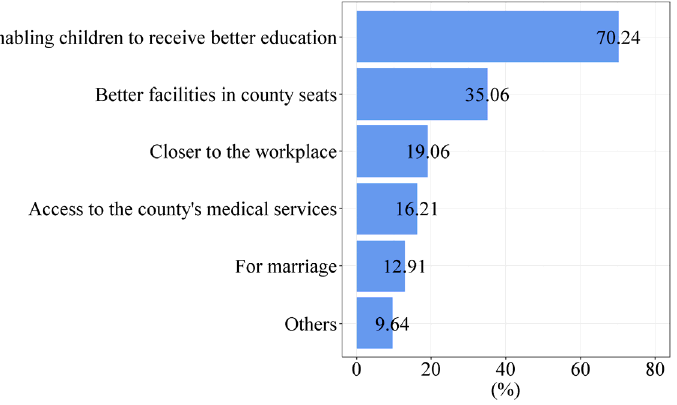
Figure 5. Reasons rural residents buy commercial houses in the county seat (Source: by the authors).